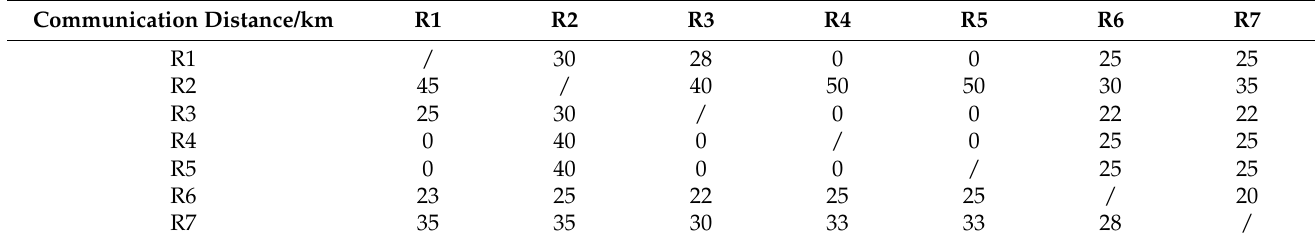
Table 8. Communication distance of the red side’s equipment.